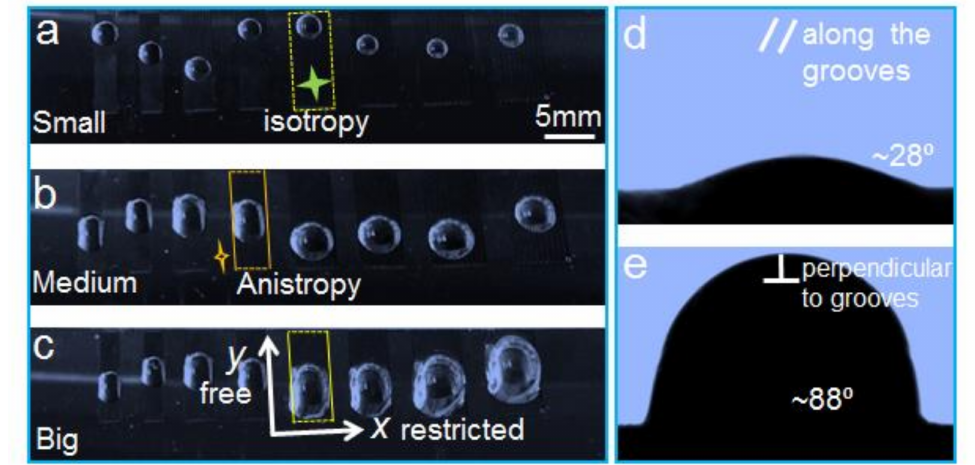
Figure 5. The anisotropic spreading of underwater bubbles on the restricted LIAMSS. ( a – c ) With the increase in bubble volume, the anisotropy spreading behavior becomes more and more obvious. ( d ) The bubble contact angle along the grooves. ( e ) The bubble contact angle perpendicular to the grooves. It is clearly seen that the BCA perpendicular to the grooves is much larger than that along the grooves, which is mainly induced by the different energy barrier in the two directions. Due to the restriction of the fabrication area, the bubble contact angle would become larger when the bubble volume increases.